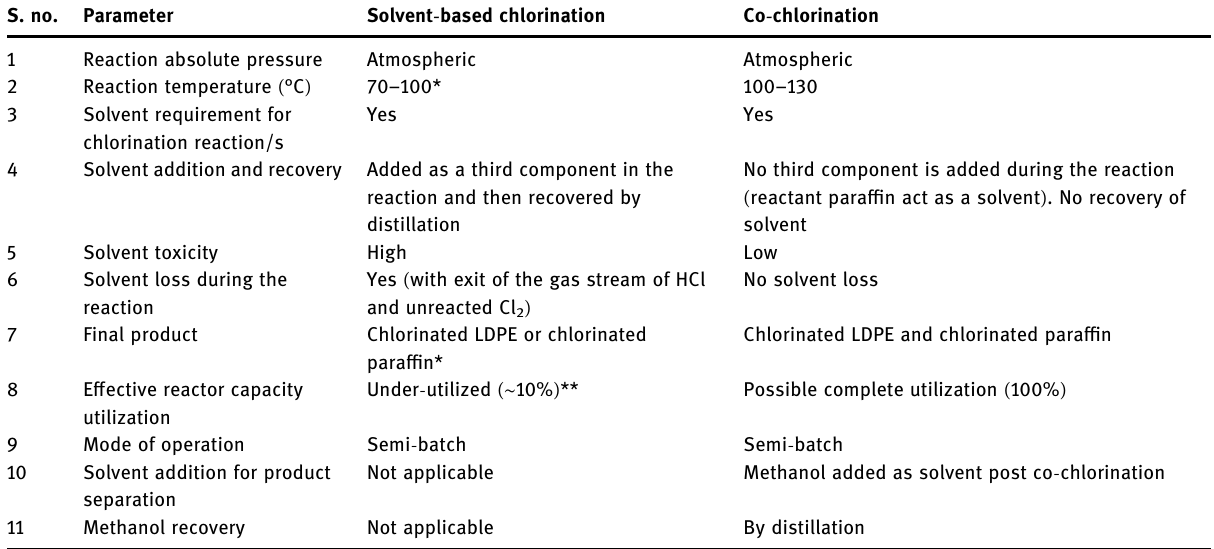
Table 7: Comparison between solvent - based chlorination and co - chlorination methods S. no.